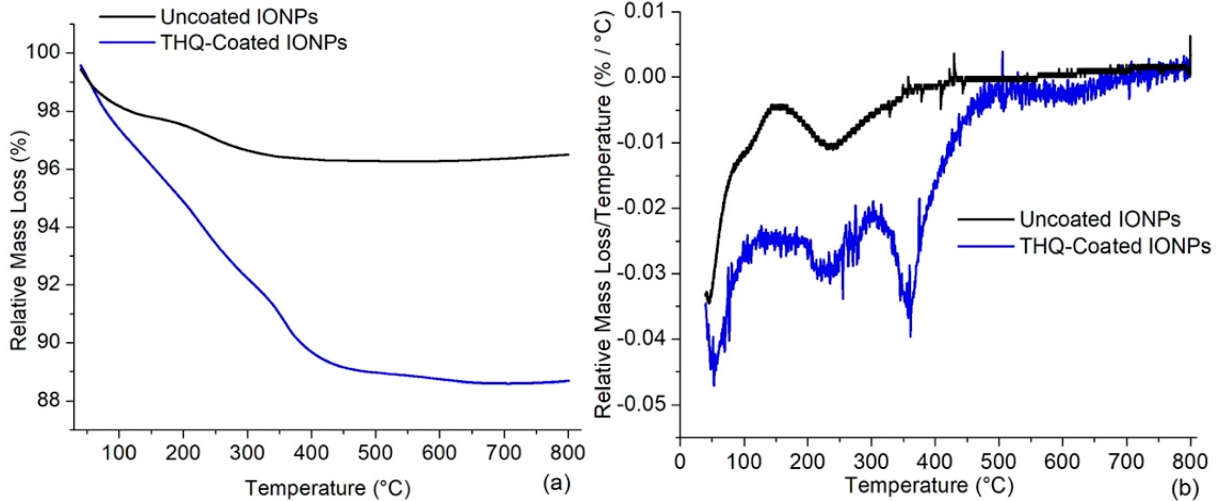
Figure 3. Thermogravimetric measurements of the mass of coated and uncoated IONPs in the interval from 40 to 800 °C ( a ) and the numerical derivative of both signals ( b ).